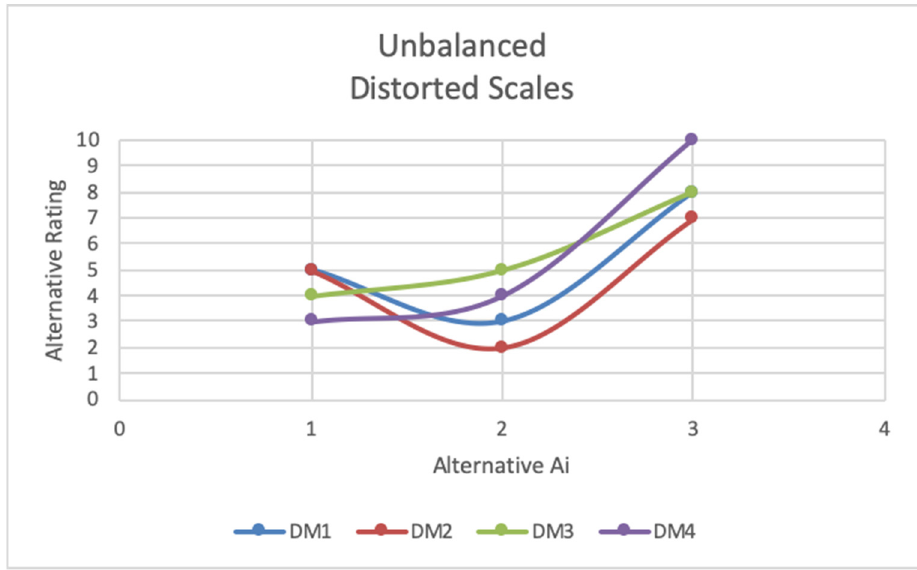
Figure 7. Case #11 unbalanced distorted scales.